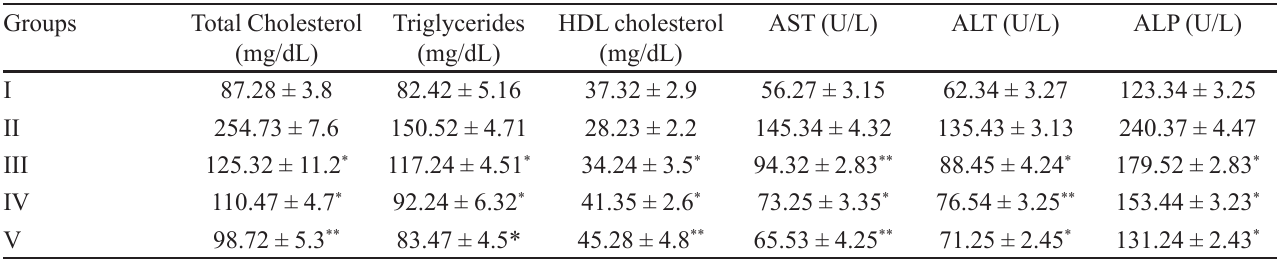
TABLE III - Effect of DIME on lipid profile and serum enzymes in diabetic rats